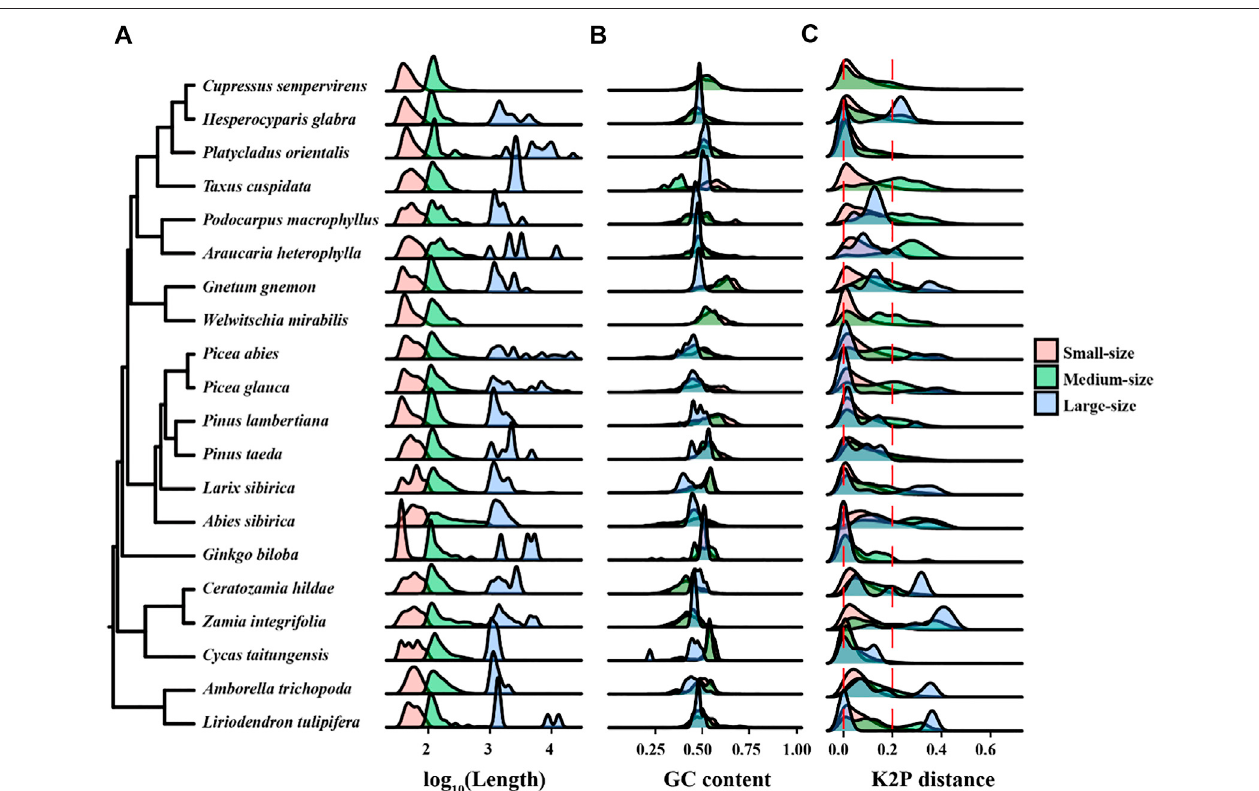
FIGURE5| Thedistributionofrepeatsize,GCcontent,andKimuta2-parameter(K2P)distanceofdispersedrepeatsineachgenome. (A) Thedensityplotshowing thelengthdistributionofthreeclassesofdispersedrepeats. (B) ThedistributionofGCcontentineachsizeclass. (C) Thedistribution ofK2Pdistancesamongdispersed repeats.Repeatsaregroupedintosmall-size( < 100 bp),medium-size(100 – 1,000bp)andlarge-size( ≥ 1,000 bp)classes.TheK2Pdistanceof0and0.2areshownwith vertical red dash line s. Note, Taxus cuspidata contains two large-size dispersed repeats with K2P values of 0 and 0.0046, respectively, which failed to show in the density plot